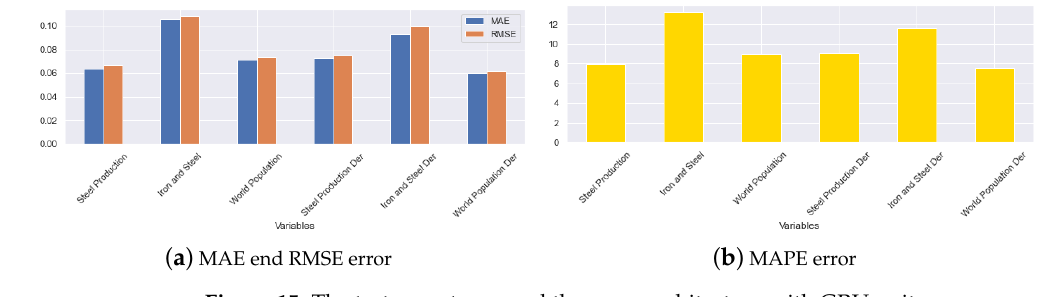
Figure 15. The test error two, used the same architecture with GRU